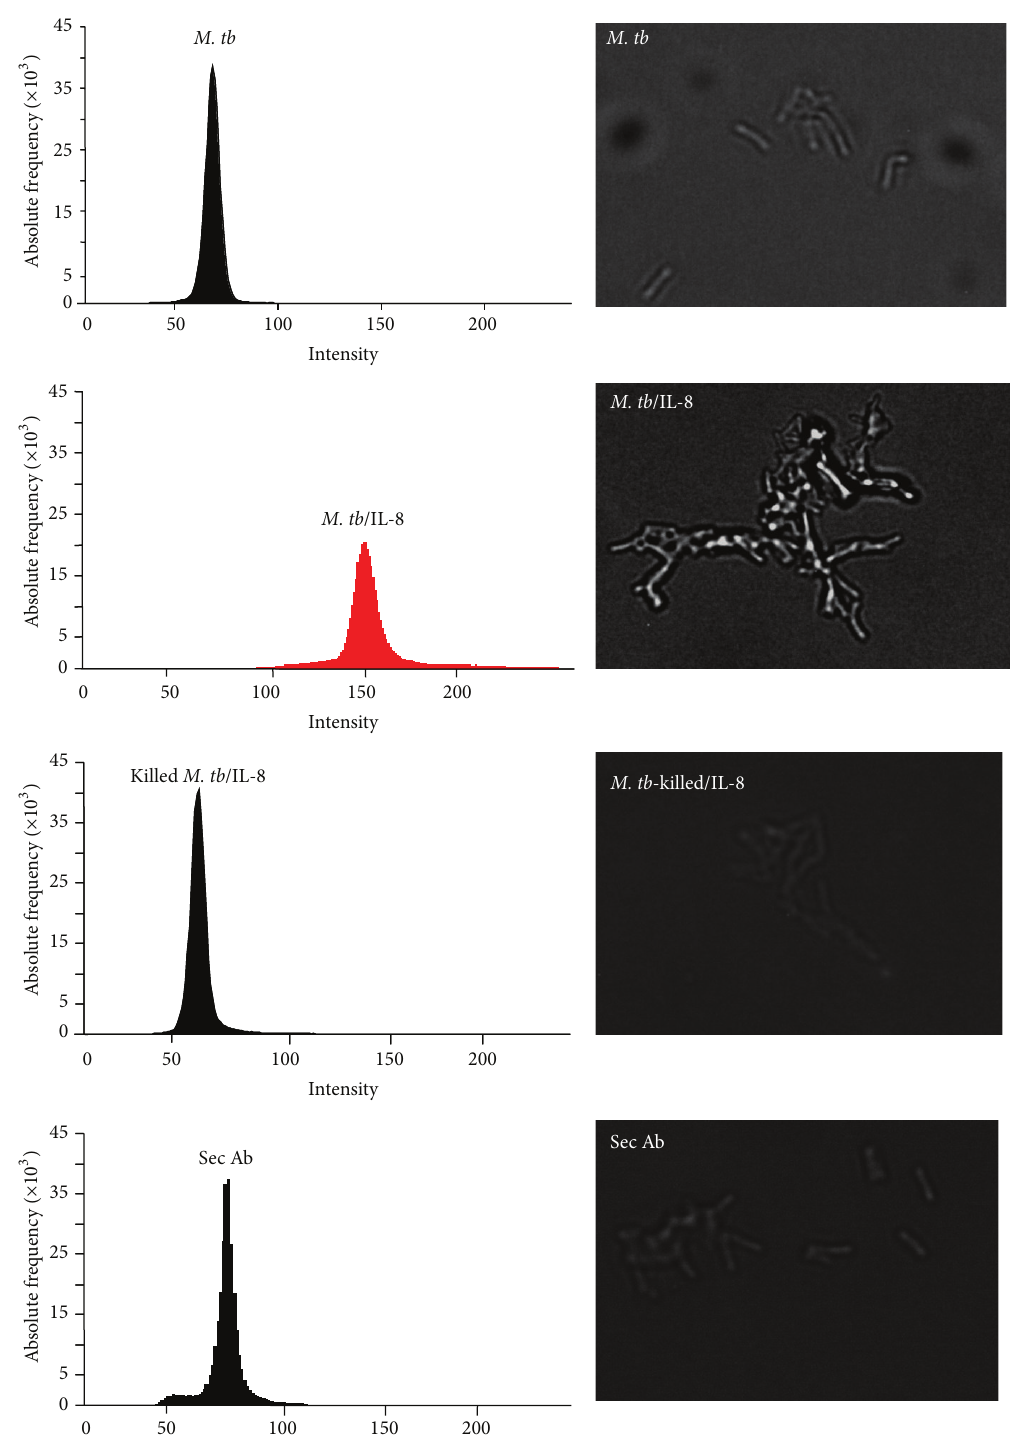
Figure 1: Binding of IL-8 to M. tb . Detection of IL-8 associated with M. tb using fluorescence